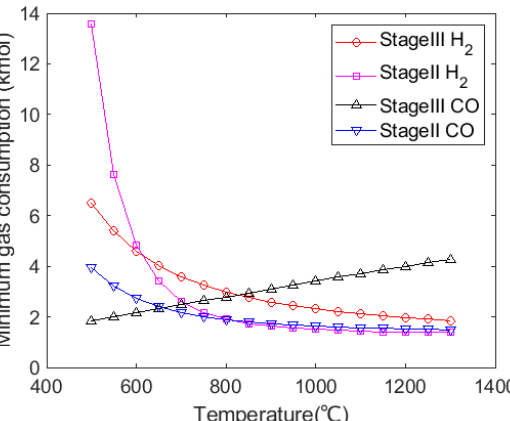
Figure 3. Variation in minimal gas consumption for iron ores reduction in pure H 2 or CO with temperature.